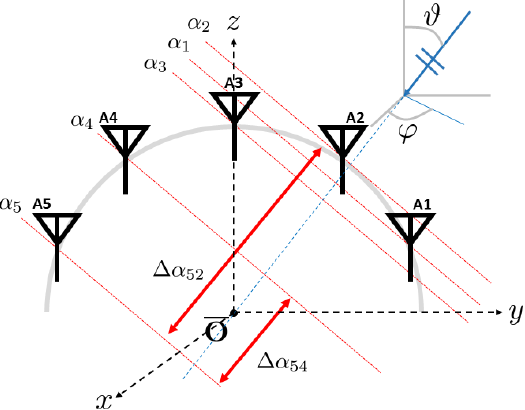
Figure 1. Scheme of an ideal Uniform Circular Array in a tridimensional